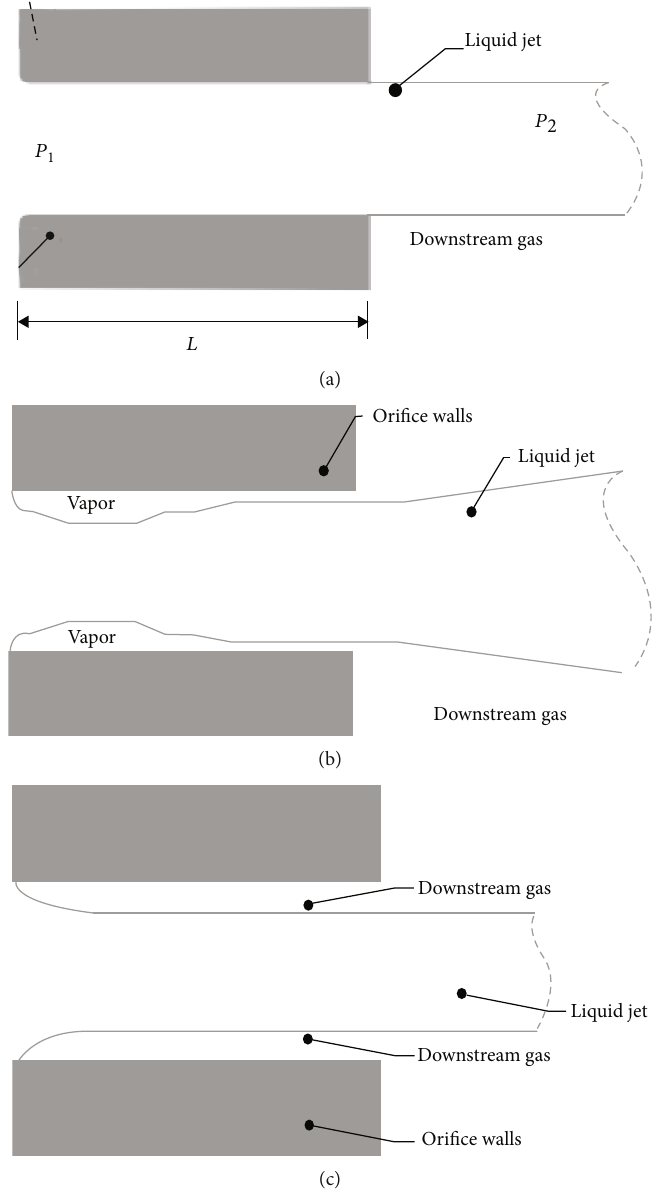
Figure 3: States of internal nozzle fl ow: (a) single-phase, (b) cavitating, and (c) fl ipped. Table 3: Theoretical values of spread parameter n for di ff erent liquid